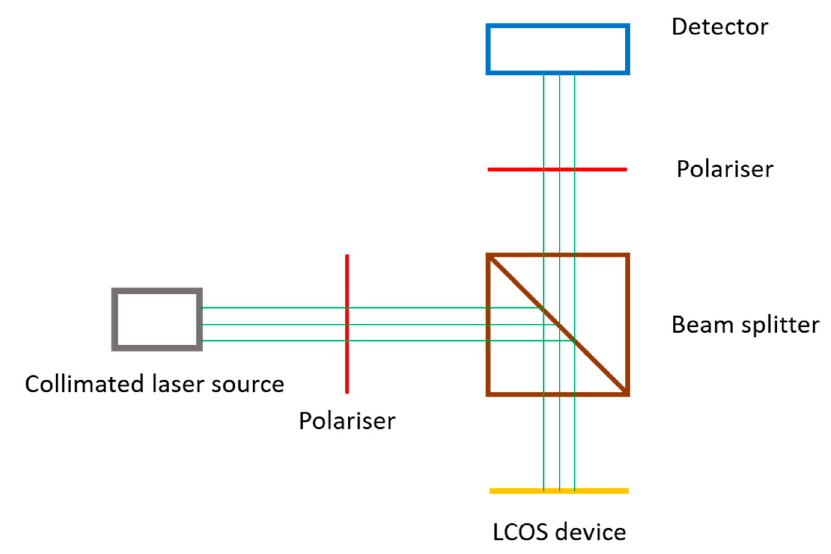
Figure 1. Experimental setup based on the crossed polarisers.